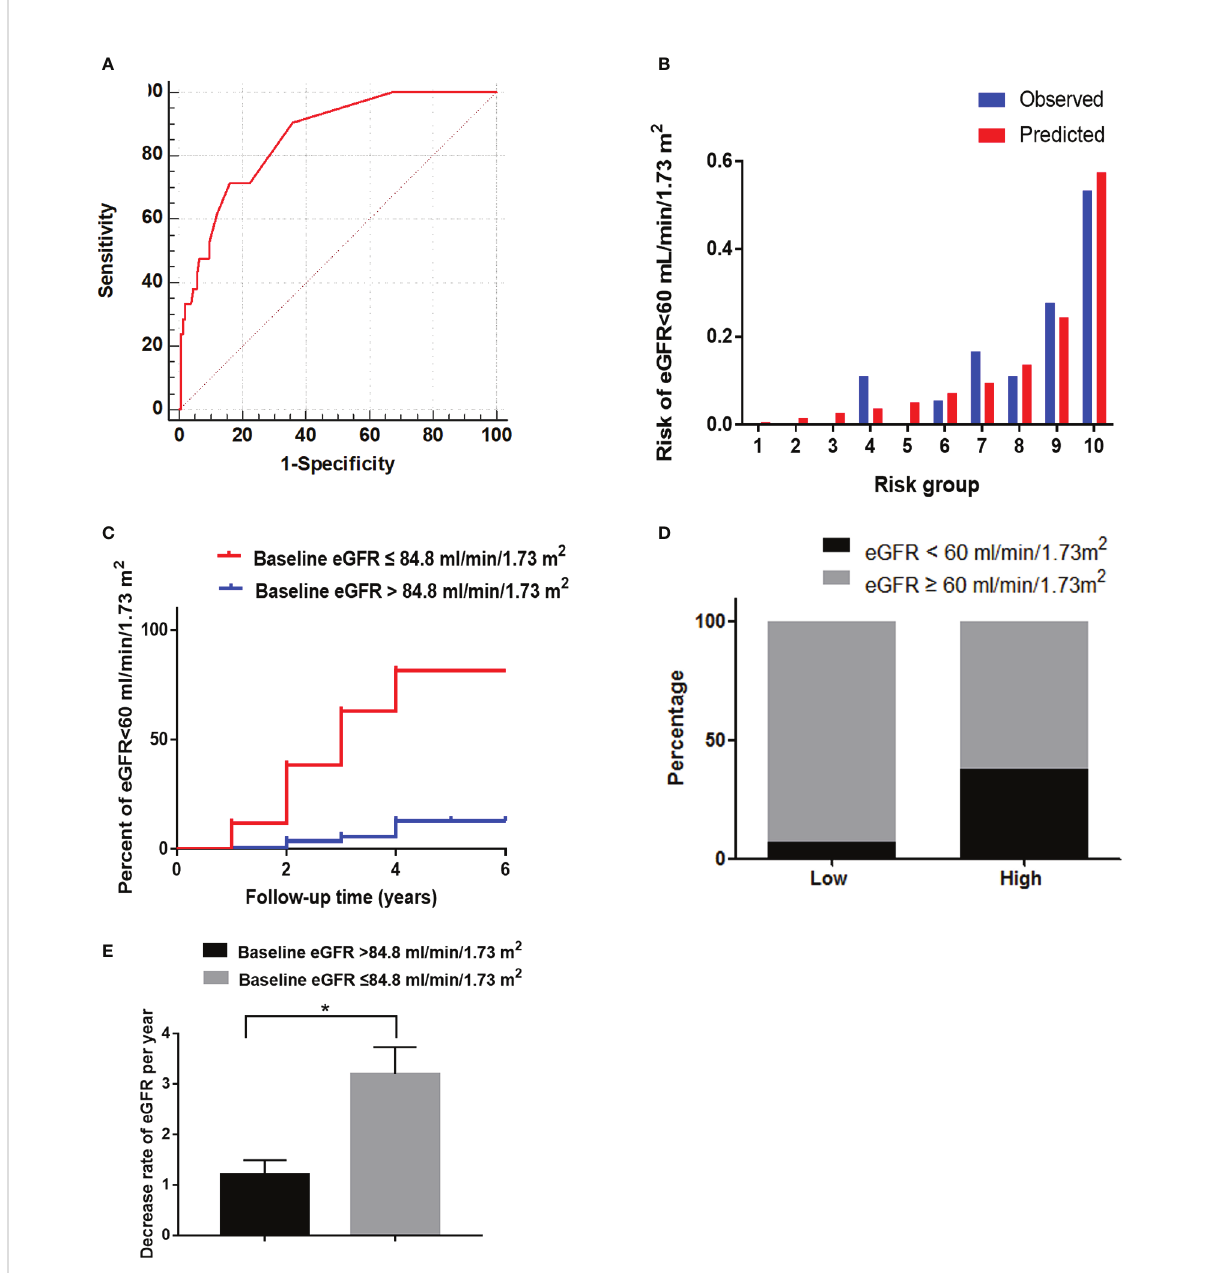
FIGURE 4 The performance of the baseline eGFR in predicting reduced eGFR in the validation cohort. (A) Receiver operating characteristic curve of baseline eGFR in predicting reduced eGFR. The area under the curve (AUC) and its 95%CI were 0.85(0.76-0.93). The sensitivity and speci fi city were 0.85 and 0.72, respectively, at 84.8 mL/min/1.73 m 2 of eGFR. (B) Hosmer-Lemeshow (H-L) test for the calibration of the baseline eGFR( P =0.17). (C) Kaplan- Meier curve of reduced eGFR end point for the low-risk (eGFR >84.8 mL/min/1.73 m 2 ) and high-risk (60 ≤ eGFR ≤ 84.8 mL/min/1.73 m 2 ) groups. The HR (95% CI) was 15.84 (4.04-24.00) ( P < 0.001) in the high-risk group. (D) Prevalence of reduced eGFR in the two risk groups. (E) The decrease rate of eGFR per year in the low-risk (eGFR > 84.8 mL/min/1.73 m 2 ) and high-risk (60 ≤ eGFR ≤ 84.8 mL/min/1.73 m2) groups. * P <